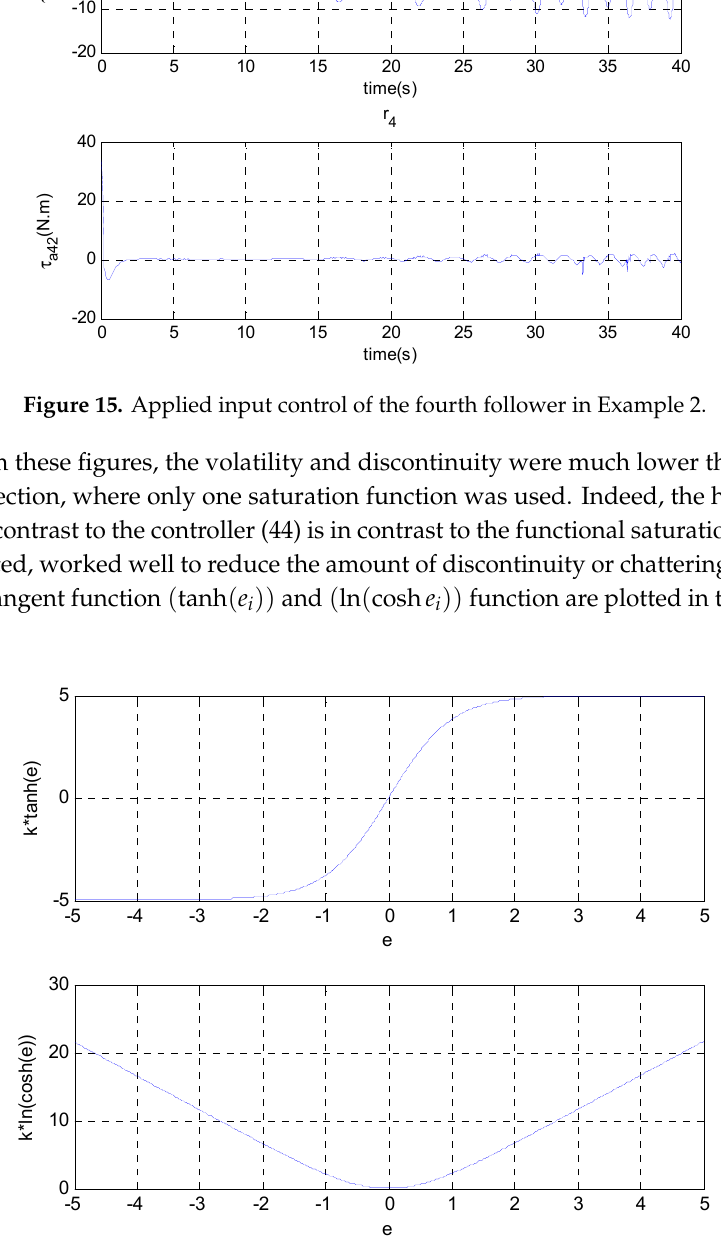
Figure 14. Applied input control of the third follower in Example 2.